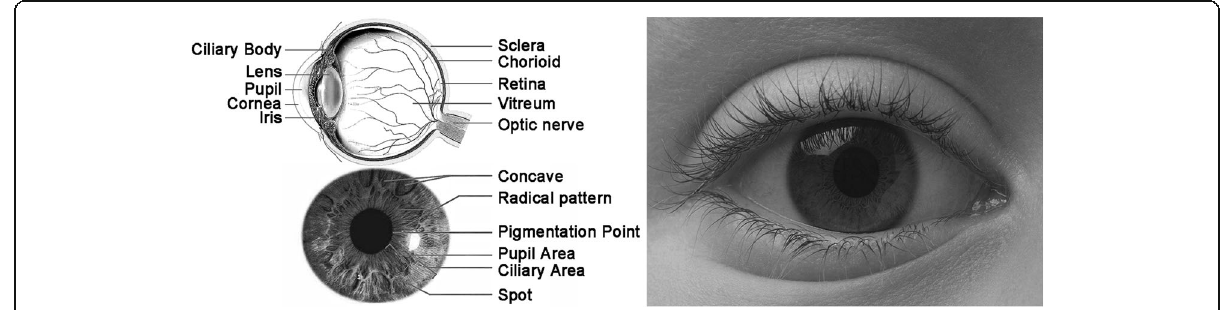
Fig. 1 Human eye structure and human eye sample